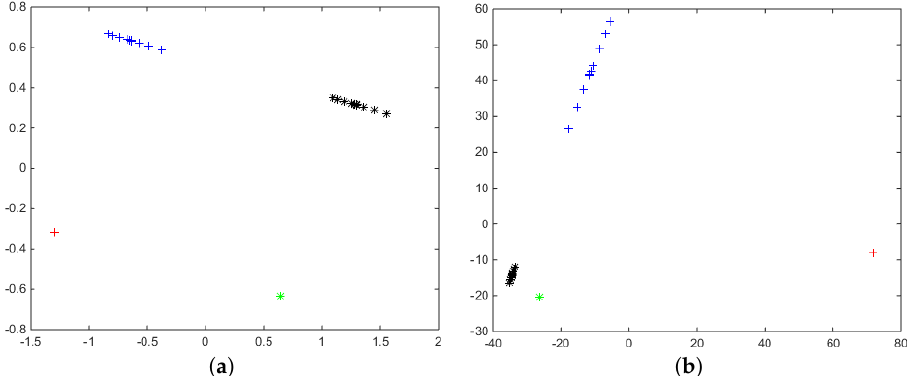
Figure 5. MDS applied to the distance matrices: ( a ) using d new , ( b ) using d 2 . The ten initial spirals are marked in green and the ten initial circumferences are represented with black asterisk, the spirals re-scaled by 50 are the red asterisks and the circumferences are plotted in blue.